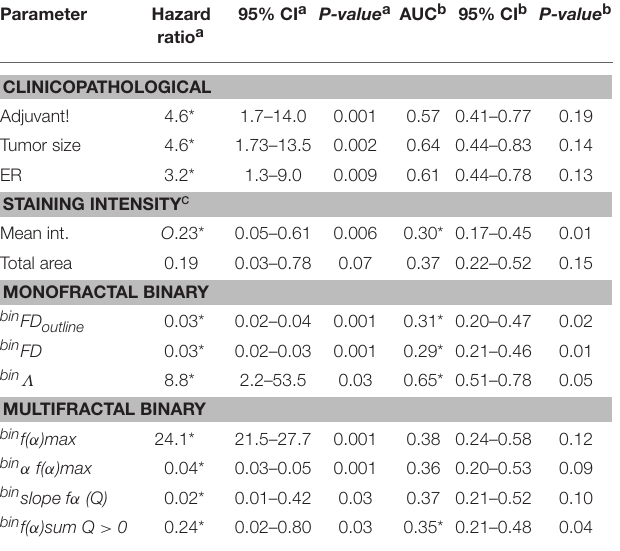
TABLE 1 | The prognostic significance of the clinicopathological, staining intensity, monofractal, and multifractal features. Parameter